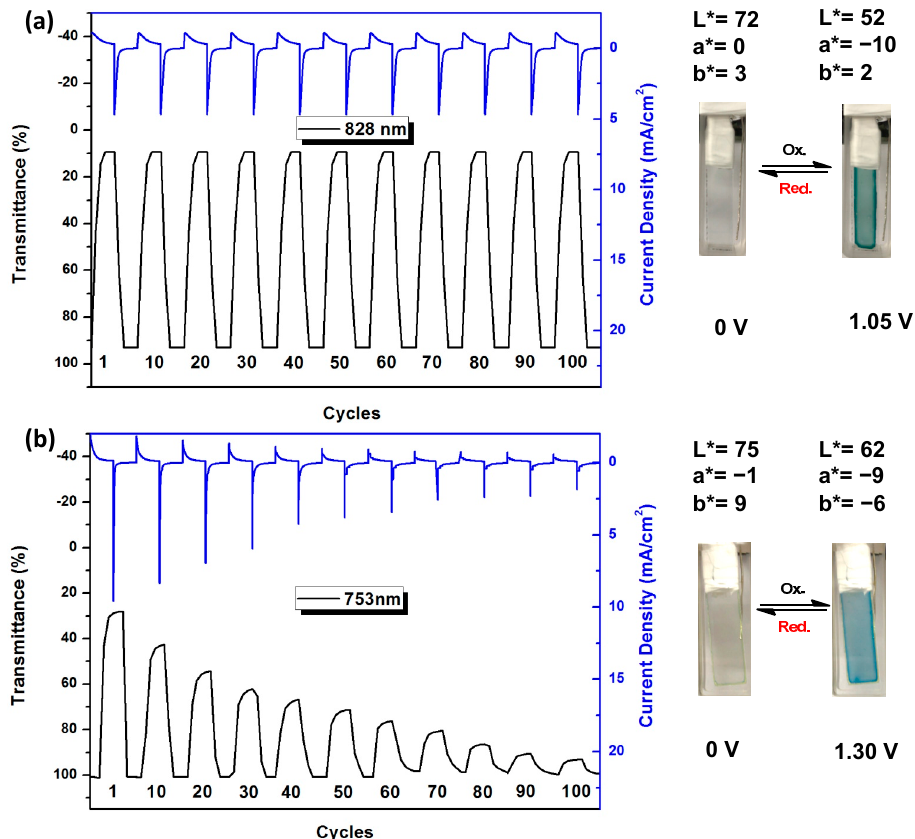
Figure 10. Cheonoabsorptometry experiments for polymer films on the ITO-glass slide (active area: 1 cm 2 , thickness: 200 ± 30 nm): ( a ) PA 5b switched between 0.0 and 1.05 V with a pulse width of 10 s; ( b ) PI 7a switched between 0.0 and 1.30 V with a pulse width of 20 s. Table 4. Coloration efficiency of polyamide 5b .